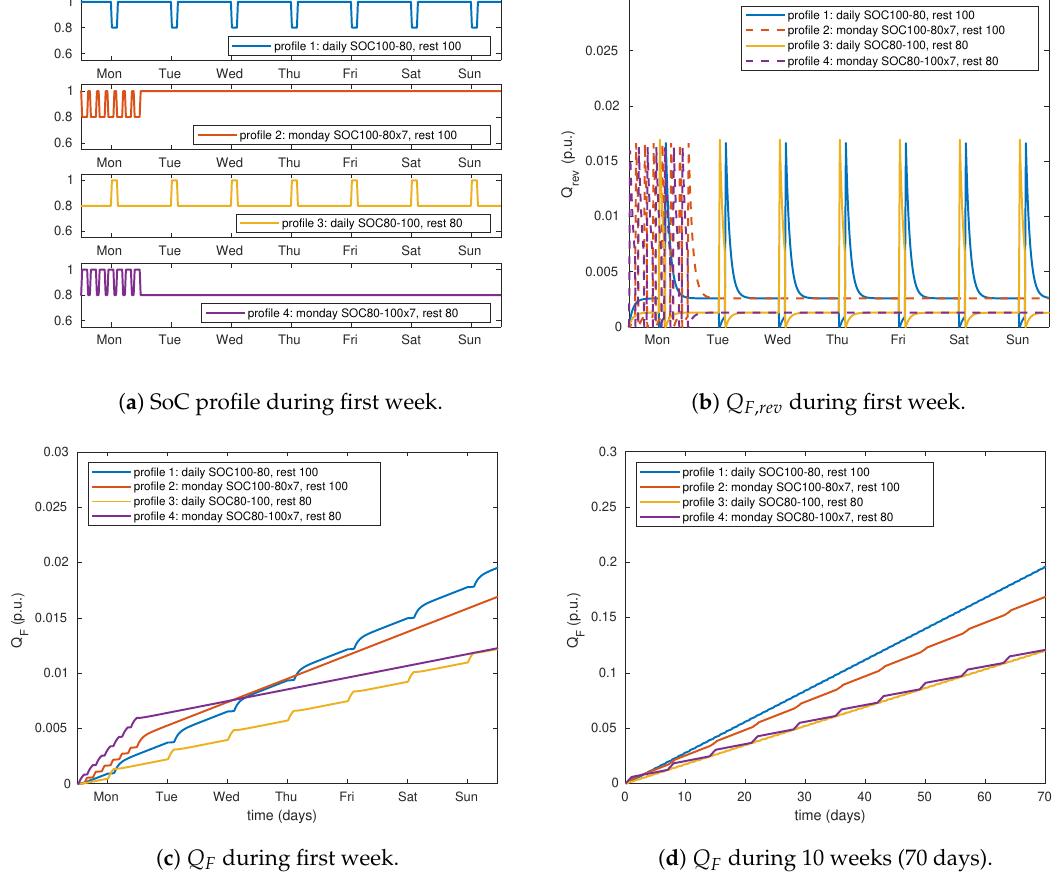
Figure 6. Simulation results for cycling profiles between SoC 100 and 80% with current rates C /2. All profiles have the same weekly charge throughput: 1.4 p.u. , that is, seven times 0.2 p.u. Profiles 1 and 2 have the same average SoC (98%) as profiles 3 and 4